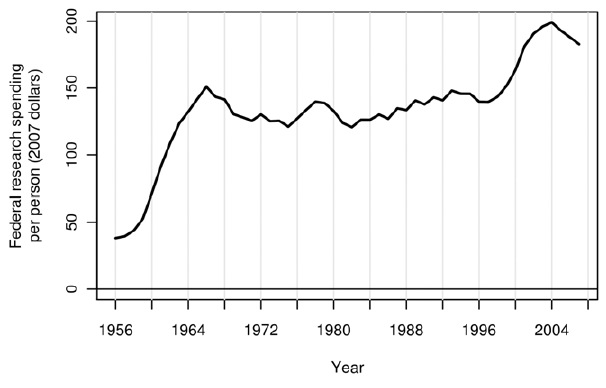
Figure 2. Per capita FRF in the US during the last six decades. FRF in inflation adjusted dollars per person.